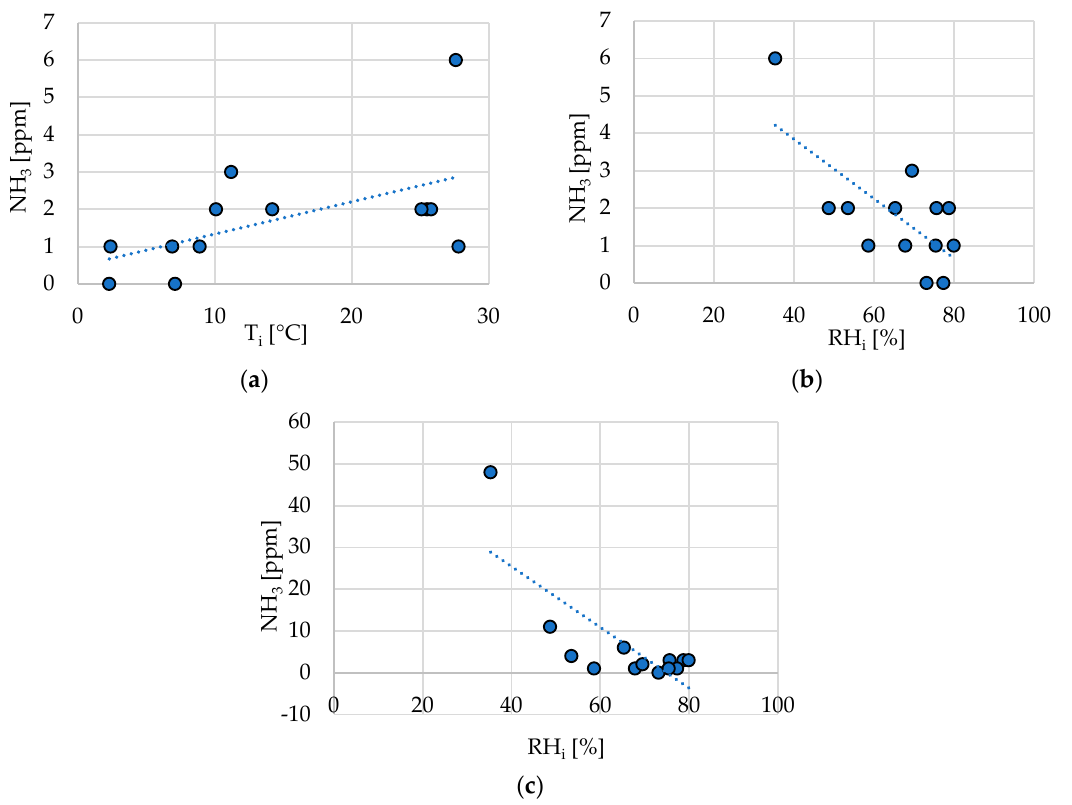
Figure 5. Correlation diagrams between NH 3 concentration in the waste storage section of biogas plant B and measured microclimatic parameters with regression lines: ( a ) inside the hall R 2 = 0.31, ( b ) selectively collected waste R 2 = 0.49, ( c ) mixed waste R 2 = 0.59.